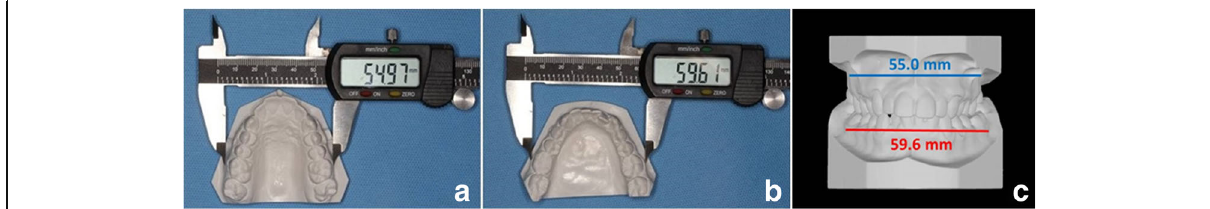
Fig. 1 Measurement of maxillary ( a ) and mandibular width ( b ) with a digital caliper on the stone models. The frontal view of maxillary (blue line) and mandibular width (red line) is shown in ( c ). In this patient, the maxillary width is 55.0 mm, the mandibular width is 59.6 mm, and the maxillary transverse deficiency is 4.6 mm (59.6 − 55.0). The amount of maxillary skeletal expansion required for the patient is equal to the maxillary transverse deficiency (4.6